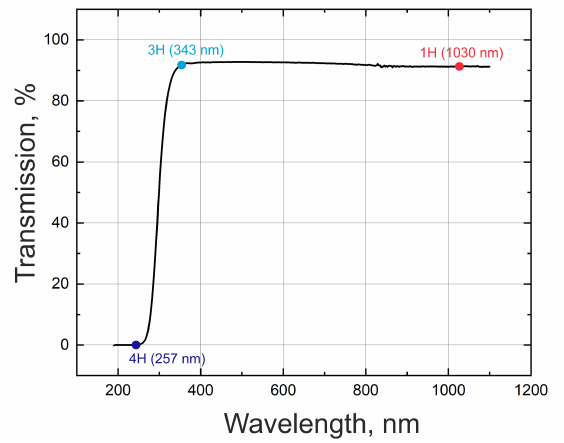
Figure 1. Transmission spectrum of a 1 mm thick soda-lime glass